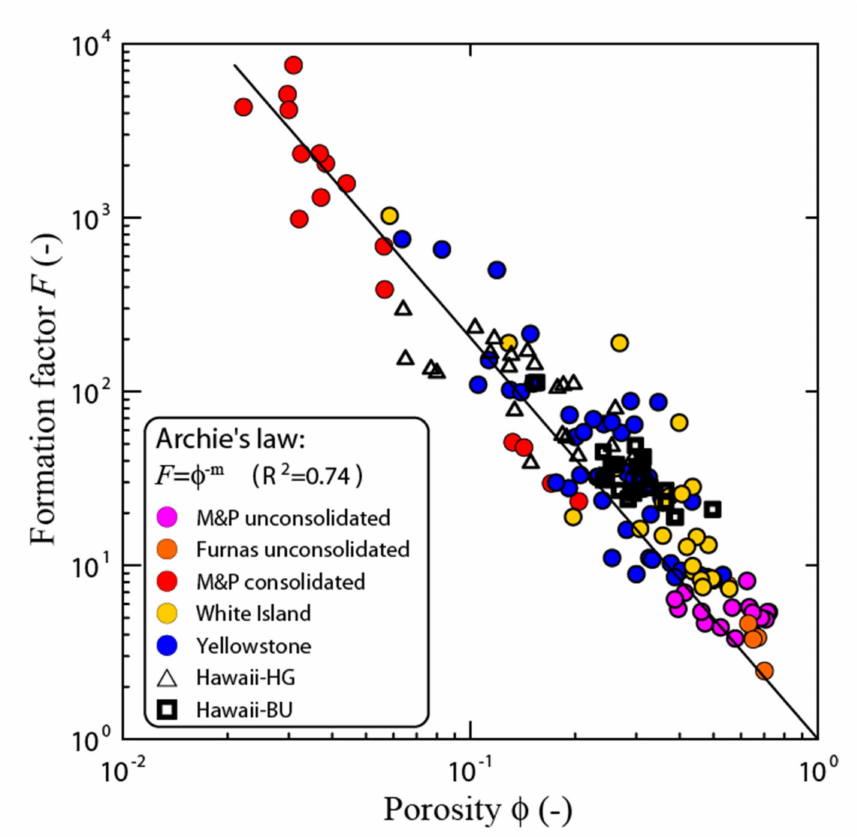
Figure 4. Formation factor F versus (connected) porosity for a set of volcanic rocks (modified from Ghorbani et al. [38]). The data are fitted with Archie’s law F = φ − m , where the mean cementation exponent is m = 2.31 ± 0.12. M&P denotes Merapi and Papandayan in Indonesia, respectively. HG and BU corresponds to two wells located on the island of Hawaii